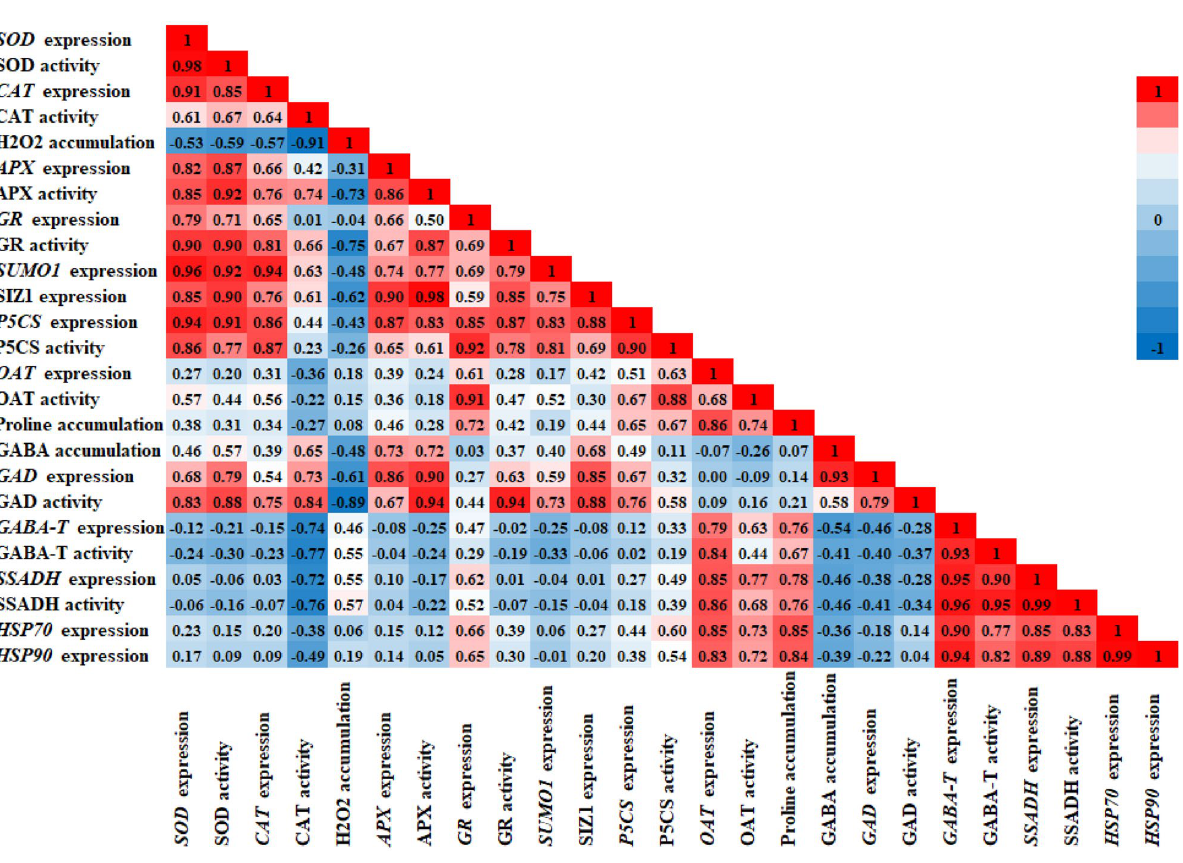
Figure 5. The Pearson correlation coefficient was calculated based on SUMO1 and SUMO E3 ligase SIZ1 genes expression, SOD , CAT , APX and GR genes expression and enzymes activity, P5CS and OAT genes expression and enzymes activity, GAD , GABA-T and SSADH genes expression and enzymes activity, and HSP70 and HSP90 genes expression accompanying by endogenous H 2 O 2 , proline and GABA accumulation of cut rose flowers in response to 0 and 150 nM PSKα